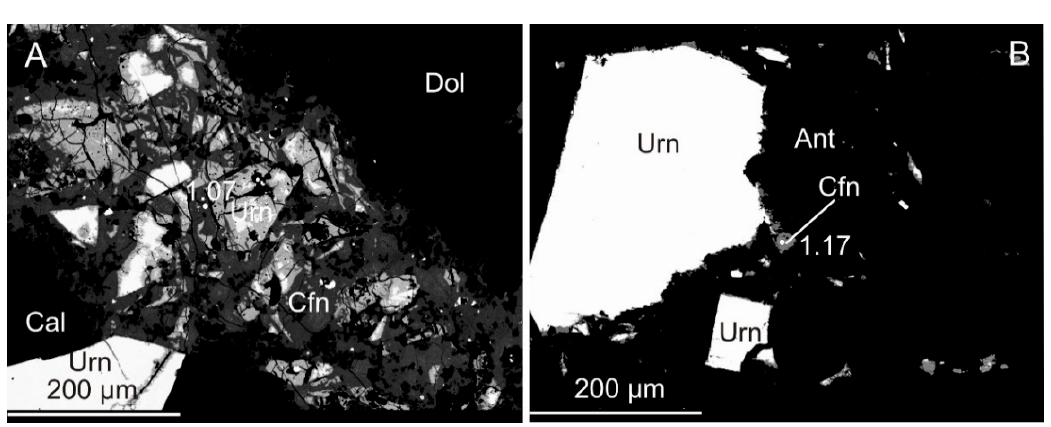
Figure 9. BSE images of uranium mineralization with distribution of Si ( apfu , O = 4) in coffinite, P ř íbram uranium district. ( A ) Distribution of Si in coffinite enclosed in calcite; ( B ) Distribution of Si in coffinite that is enclosed in antraxolite. Urn—uraninite, Cfn—coffinite, Ant—anthraxolite, Cal—calcite, Dol—dolomite.